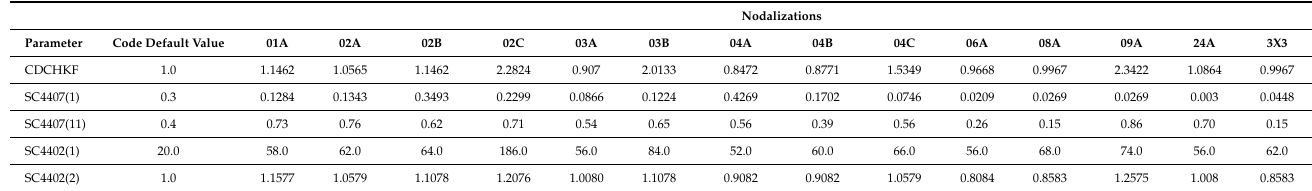
Table 5. “Best-fit” parameter values for the different nodalizations.